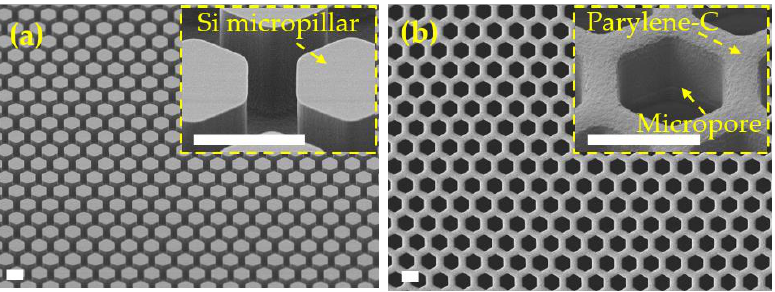
Figure 6. Fabrication results of the Parylene C molding process with a silicon template. ( a ) Si micropillars prepared via photolithography micropatterning and DRIE; ( b ) the prepared Parylene-C micropore array. The scale bars are 10 µ